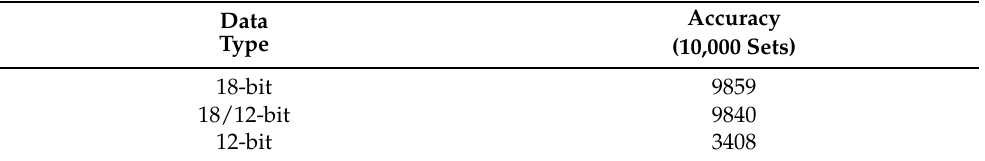
Table 3. Classification accuracies with varying data precision.